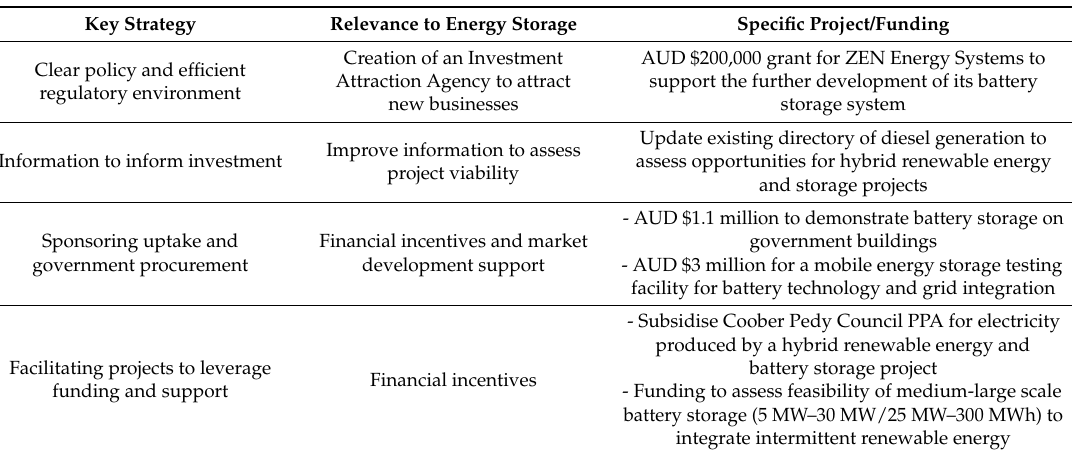
Table 7. A Low Carbon Investment Plan key strategies